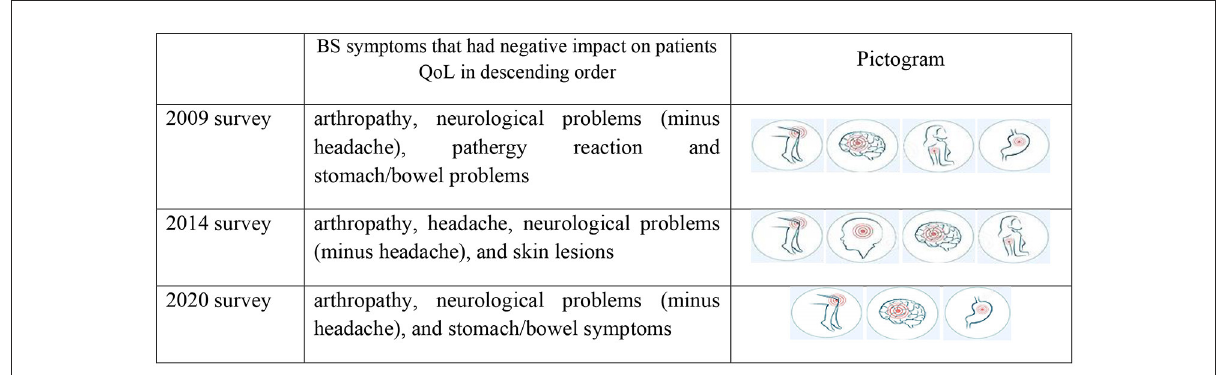
FIGURE4 Pictogram shows the descending order of main BS symptoms that have negative impact on patients QoL. Both arthropathy and neurological problems presented in three different time points as a main problems that effect on patients’ HRQoL. Source: https://st2.depositphotos.com/ 1411892/6582/v/950/depositphotos_65828131-stock-illustration-body-pain.jpg.